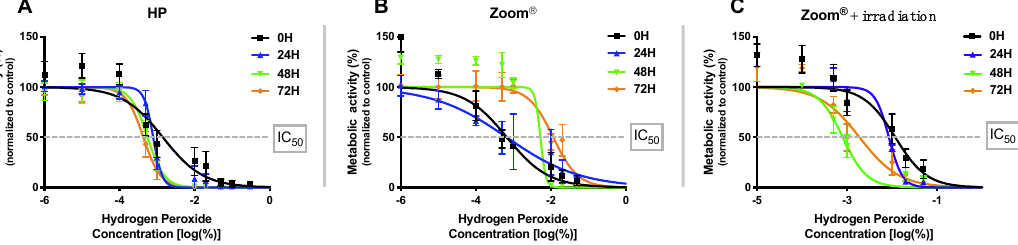
Figure 1. Dose–response curves at 0 h, 24 h, 48 h, and 72 h, for hydrogen peroxide (HP) ( A ), Zoom ® ( B ), and Zoom ® + irradiation ( C ), expressed as the dose-related inhibition of cell proliferation, determined by the MTT assay. The results express the average of 6 independent experiments ± standard error.